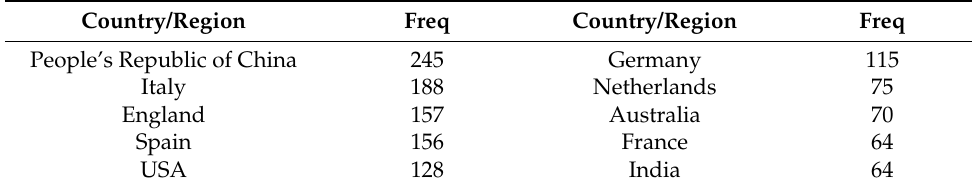
Table 4. List of Top 10 country or region with the Most Published Numbers. Country/Region Freq Country/Region